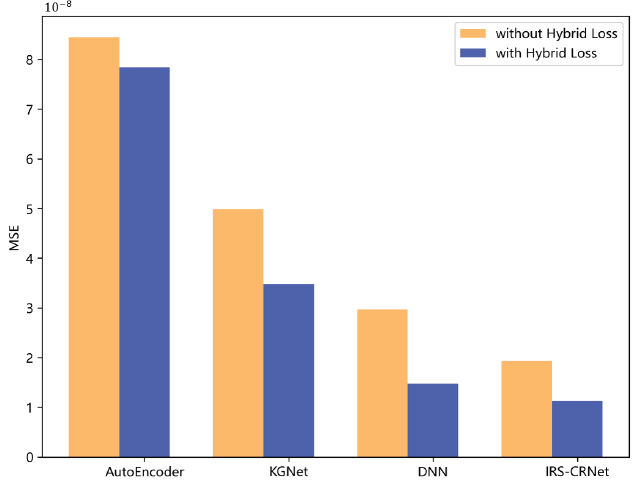
Figure 7. The MSE of four different models trained with Loss h and without Loss h